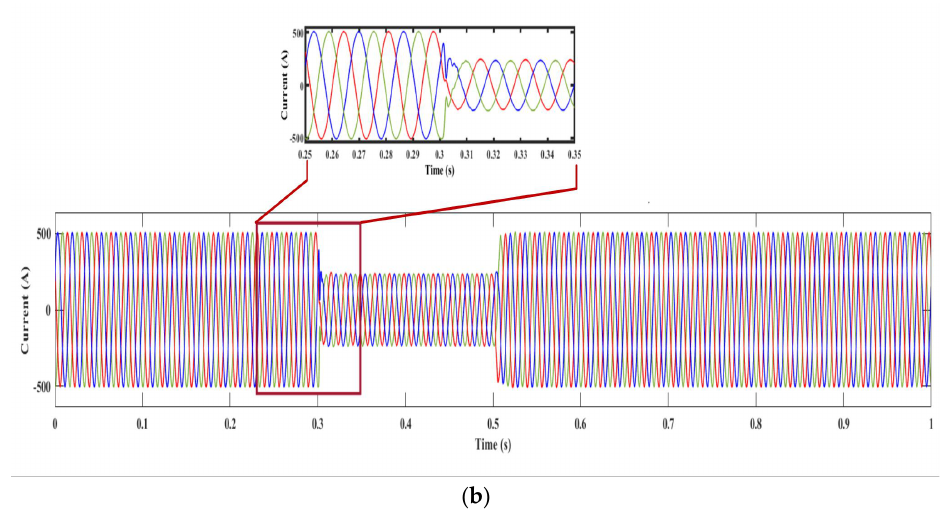
Figure 8. Analysis of ( a ) Bus 6 voltage and ( b ) Bus 6 current under power swing conditions.